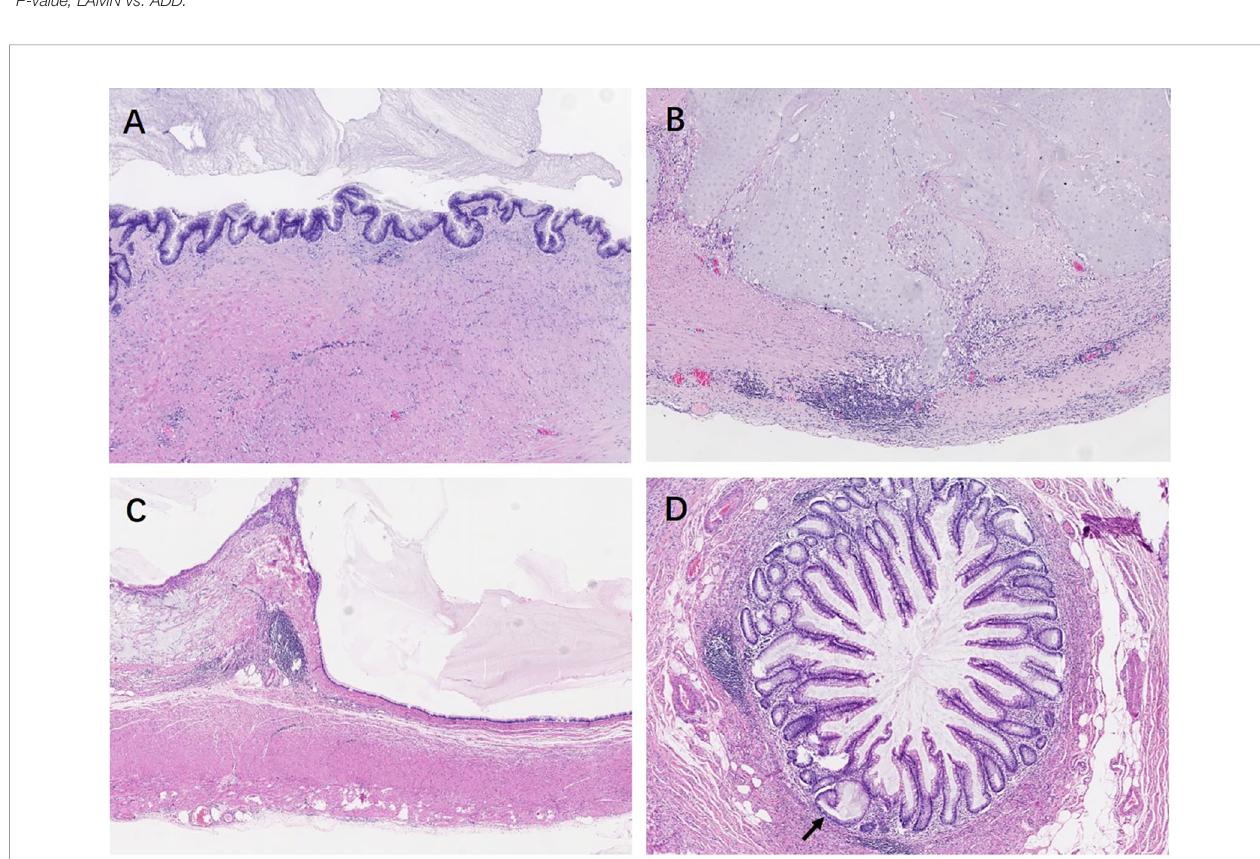
FIGURE 1 | Low-grade appendiceal mucinous neoplasms. (A) LAMN is characterized by loss of the lamina propria and muscularis mucosae and fi brosis of the submucosa. The mucosa is replaced by an undulating neoplastic mucinous epithelium that demonstrates low-grade cytologic dysplasia. (B) By thorough sampling and evaluation, this case is con fi rmed as pT3 stage with subserosa involvement of acellular mucin. (C) The neoplastic mucinous epithelium has a fl attened architectural arrangement. Note the dissected mucin in the wall on the left. (D) Other section without lumen dilation shows the serrated lesions with L-shaped serrations in the basal crypt (black arrow).